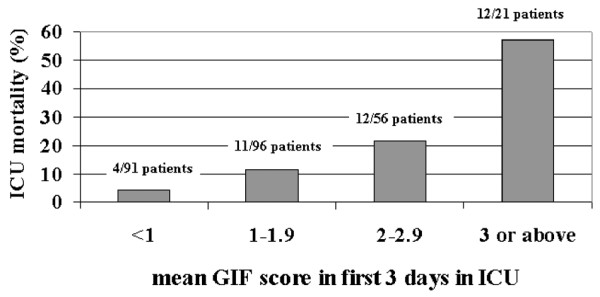
ICU mortality of patients according to their mean GIF score. ICU, intensive care unit; GIF, Gastrointestinal Failure (score).